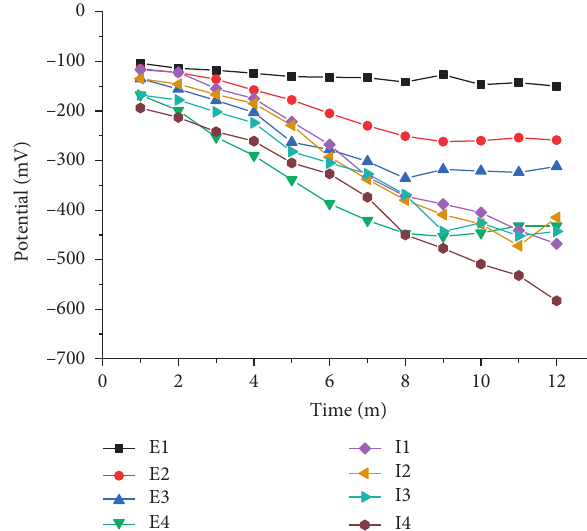
Figure 8: Potential of brushing